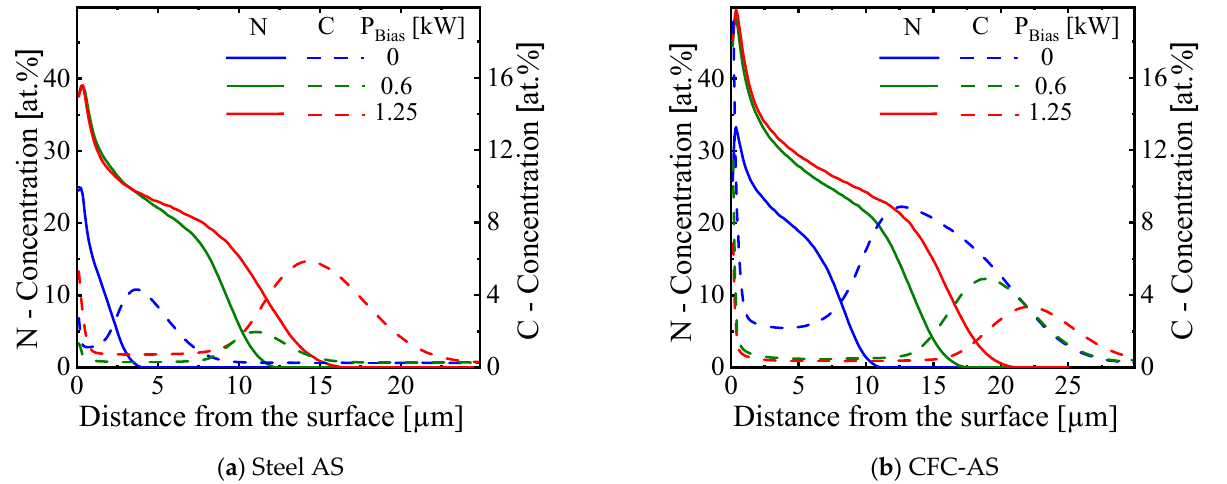
Figure 11. GDOES concentration depth profiles of nitrogen and carbon (in at.%) after ASPNC treatment at different bias conditions for a steel AS ( Φ CH4 = 4 slh) ( a ) and a CFC-AS ( b ) at H 2 :N 2 = 1:1, p = 3 mbar, T = 460 °C, Φ Total = 80 slh, and t = 5 h.